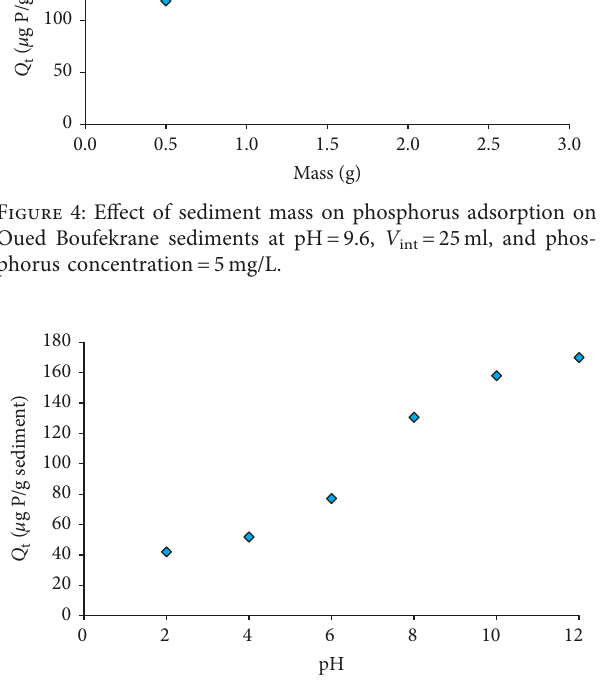
Figure 5: Effect of pH on phosphorus adsorption on Oued Boufekrane sediments at T � 24 ° C, V int � 25 ml, and phosphorus concentration �